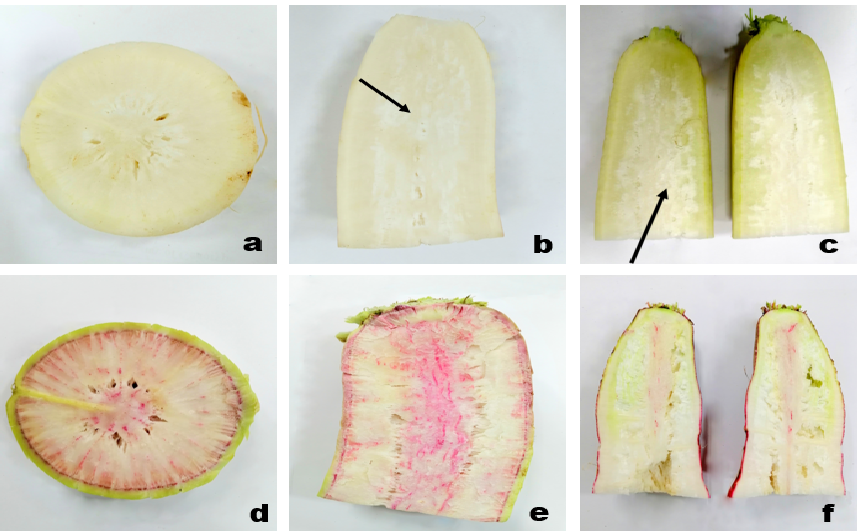
Figure 3. Pithiness disorder induction in different radish cultivars: cross section of pithed roots (( a ): Minowase), moderate pithiness exhibiting dull white tissue in the longitudinal section of young roots represented by black arrow (( b ): Bari white, ( c ): Green neck), over mature root that leads to pore development in cross section (( d ): Lalpari), and longitudinal section (( e ): Lalpari, ( f ): Bari Red).